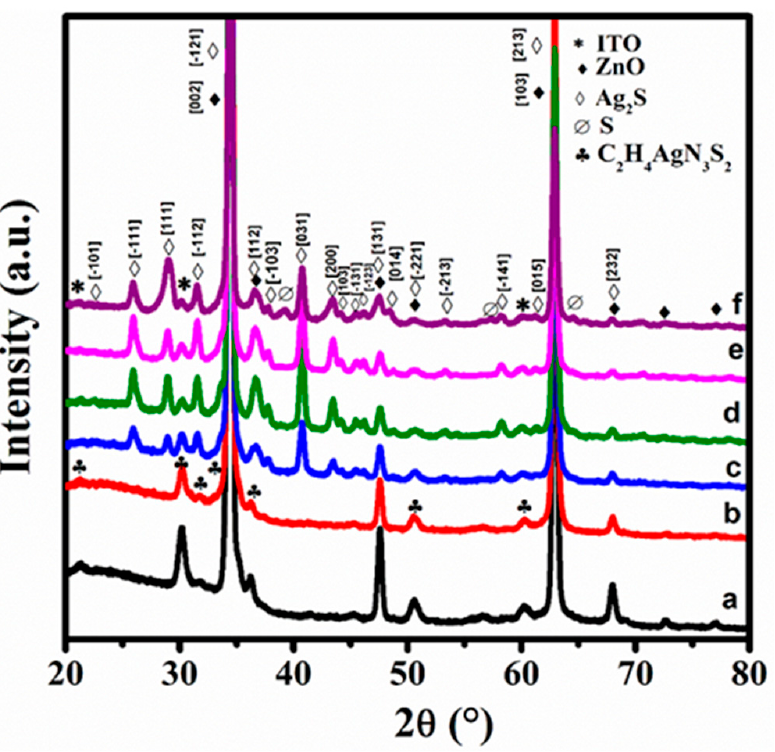
Figure 2. X-ray diffractogram of ZnO NRs ( a ), Ag 2 S/ZnO NRs/ITO with various concentrations of AgNO 3 : ( b ) 0.001 M; ( c ) 0.003 M; ( d ) 0.005 M; ( e ) 0.008 M; and ( f ) 0.01 M.